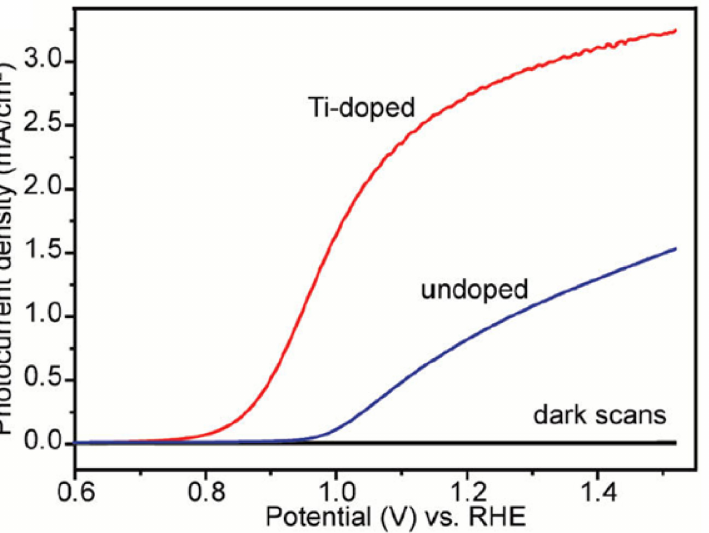
Figure 4. Comparison of photocurrent densities collected for optimized undoped and Ti-doped hematite films. Reproduced with permission from [65]. Copyright American Chemical Society,